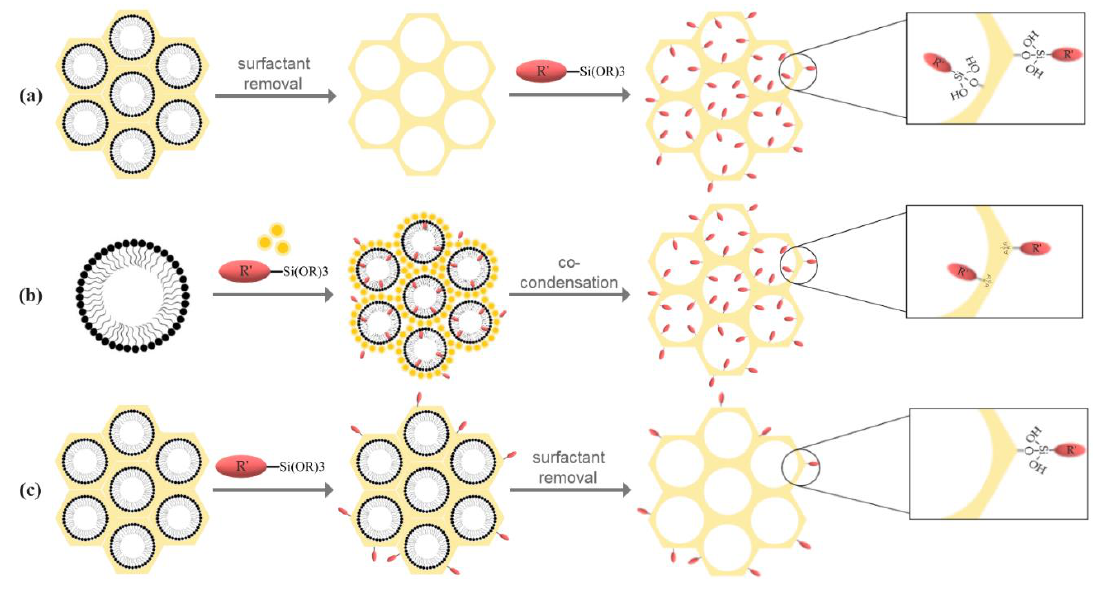
Figure 5. The main strategies for surface functionalization: ( a ) post-synthetic grafting; ( b ) co- condensation; ( c ) post-synthetic grafting followed by template